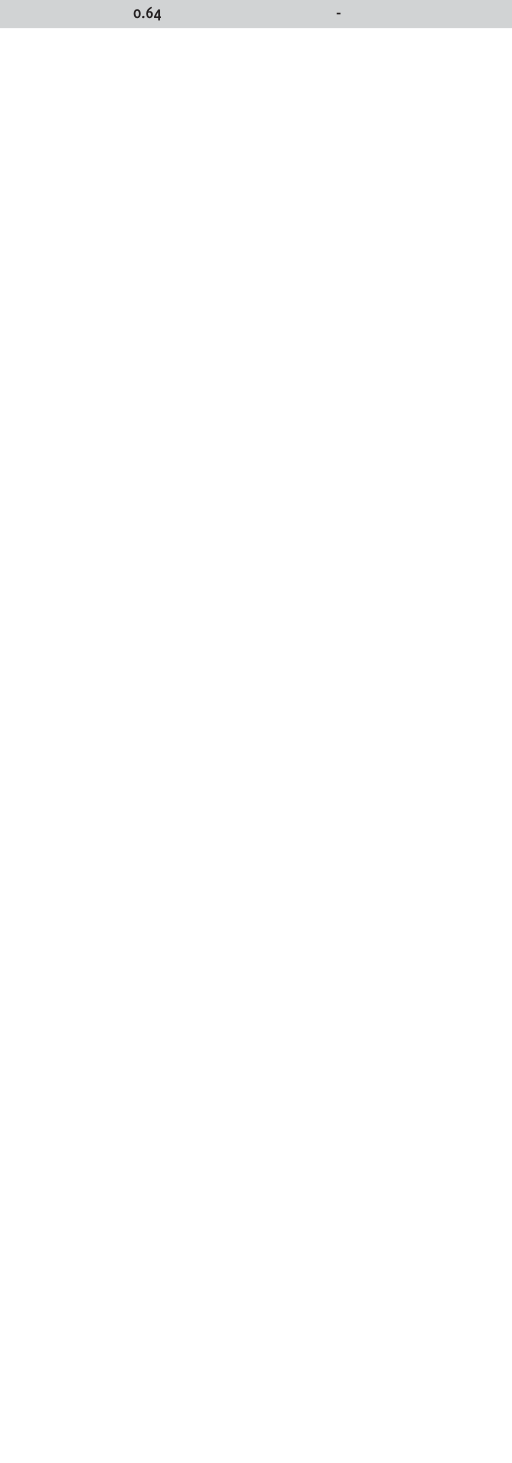
being uninterested, and might lead us to interpret the results obtained as being an overrepresentation of the actual number of students who deemed research a topic of